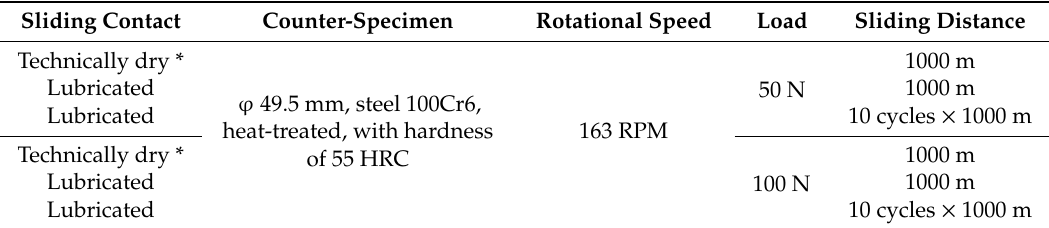
Table 2. Wear test parameters.